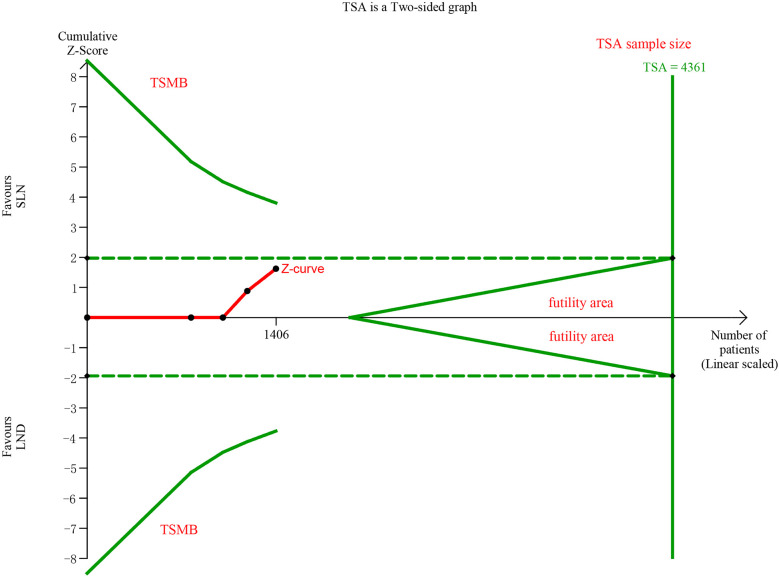
TSA of pelvic lymph nodes removed, α = 0.05, β = 0.8, two-sided test.